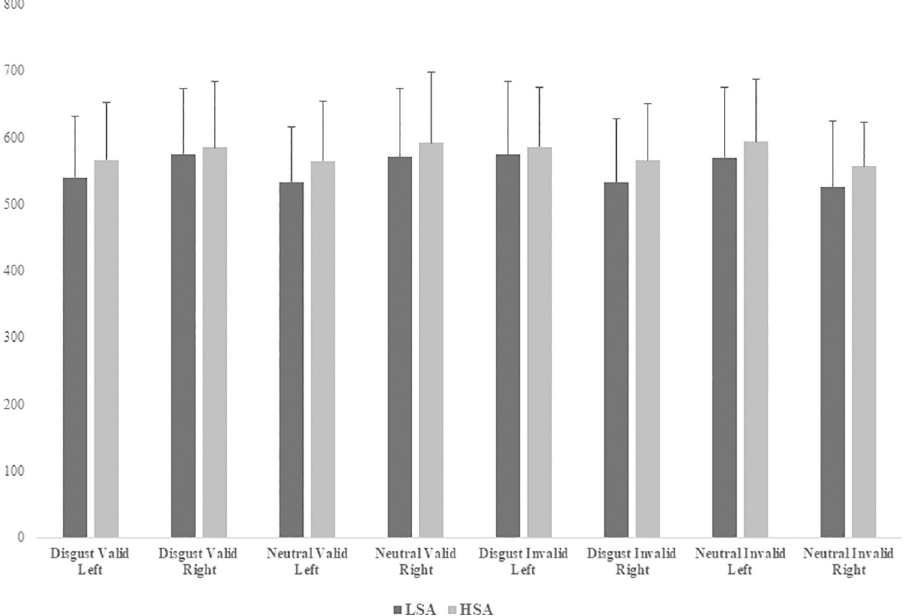
Fig 1. Mean reaction times (in milliseconds) obtained by each group of children in each experimental condition of the emotional spatial-cueing task.